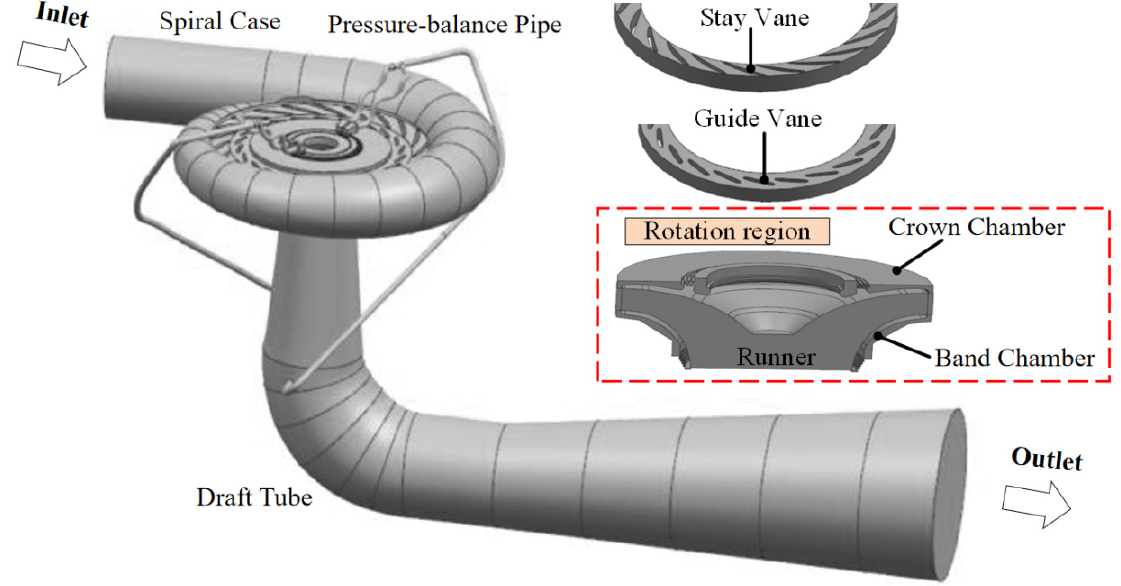
Figure 2. 3D models and the boundary conditions of the flow field simulation [26].